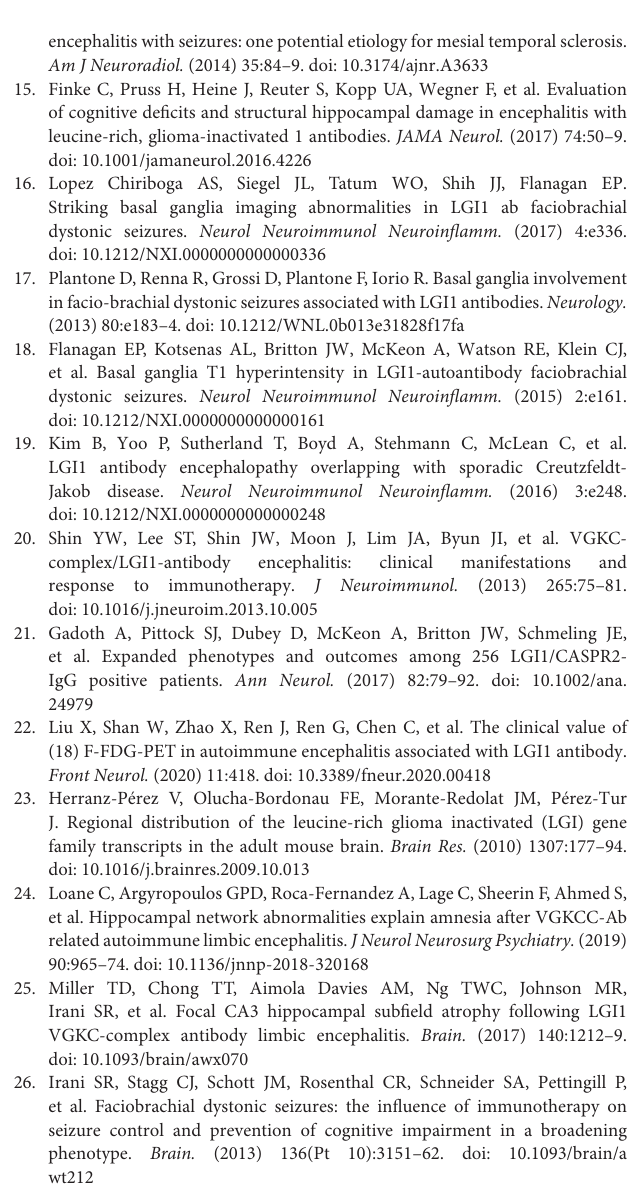
Supplementary Figure 1 | Lesion overlap maps for male and female patients. The lesion overlap maps were very similar of male and female patients, except for some differences in the location of basal ganglia lesions. Supplementary Figure 2 | Lesion overlap maps for patients with and without faciobrachial dystonic seizure. There were more basal ganglia lesions in patients with faciobrachial dystonic seizure (FBDS) compared with those without FBDS. Supplementary Table 1 | Modified Rankin Scale for neurologic